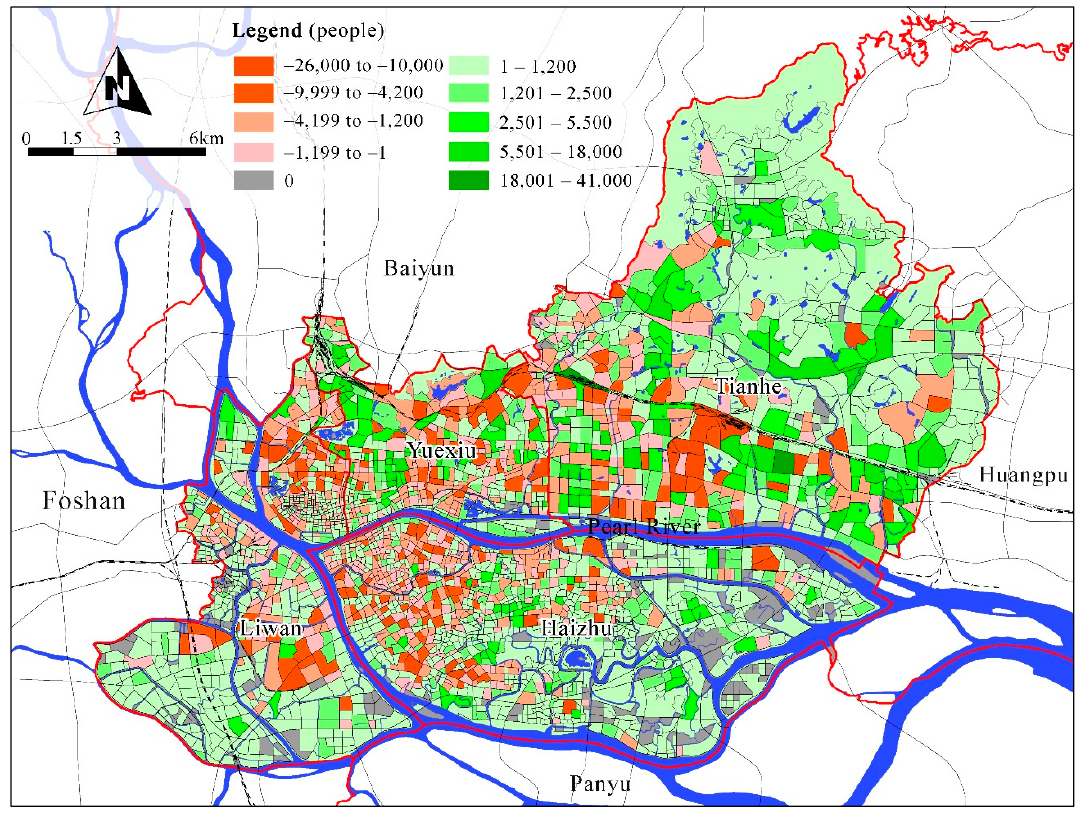
Figure 5. The population change of the plots between day and night. Table 3. The number of plots with a maximum population and the population change by district. Plots with Pop. Increase over Plots with Pop. Increase Plots with District a Daytime Max Pop. Nighttime a Nighttime Max Pop. over Daytime Equal